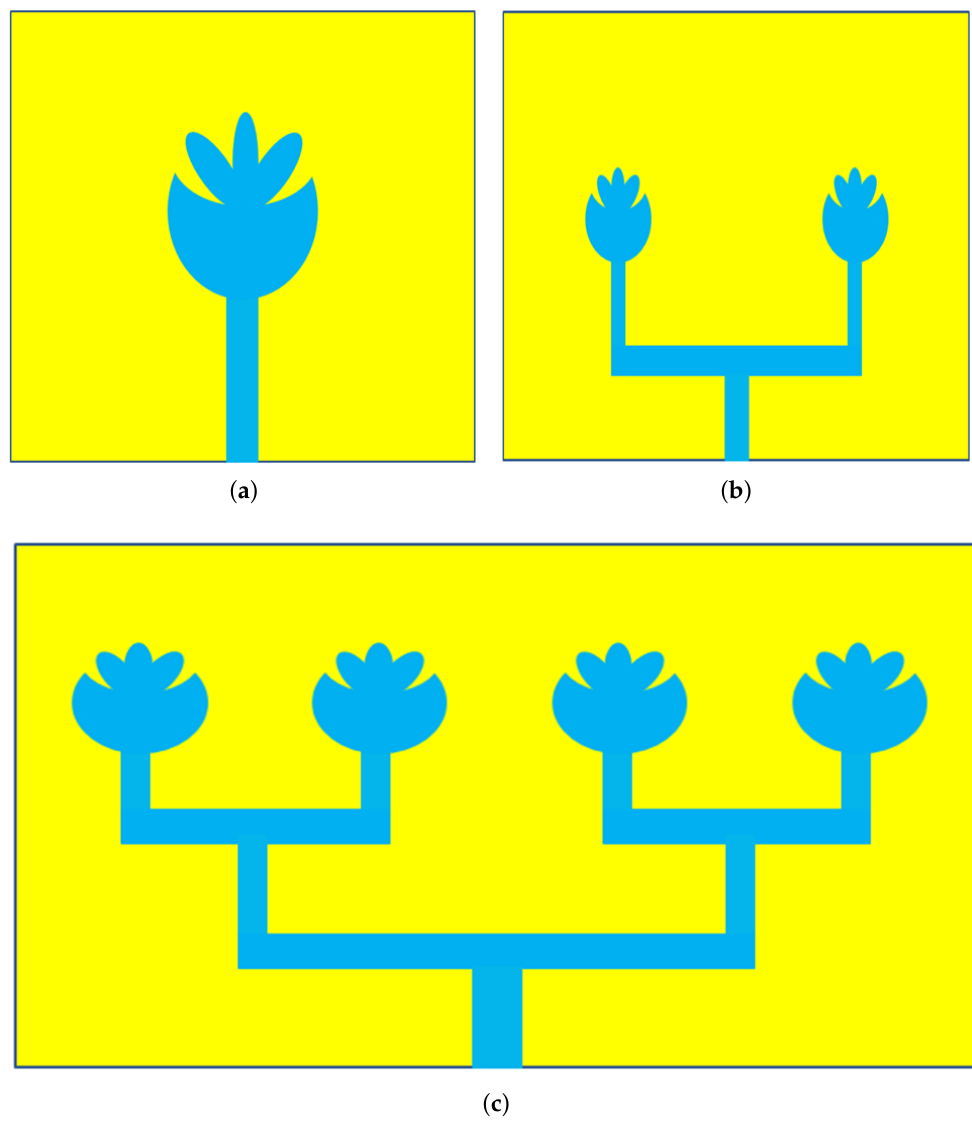
Figure 4. Design procedure of novel shape dual-band THz antenna array: ( a ) Type A antenna; ( b ) Type B antenna array; and ( c ) Type C antenna